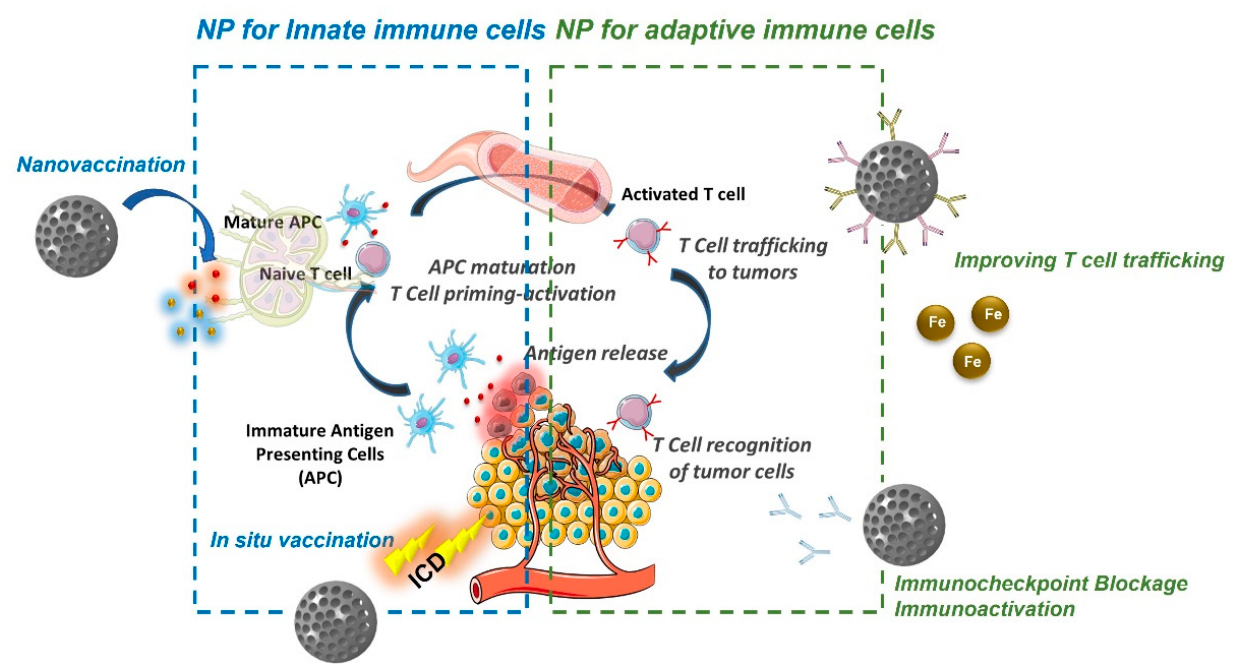
Figure 1. Nanomedicine-based strategies to reboot the cancer-immunity cycle. Figure Reproduced from Ref. [27], Molecules, 2020.